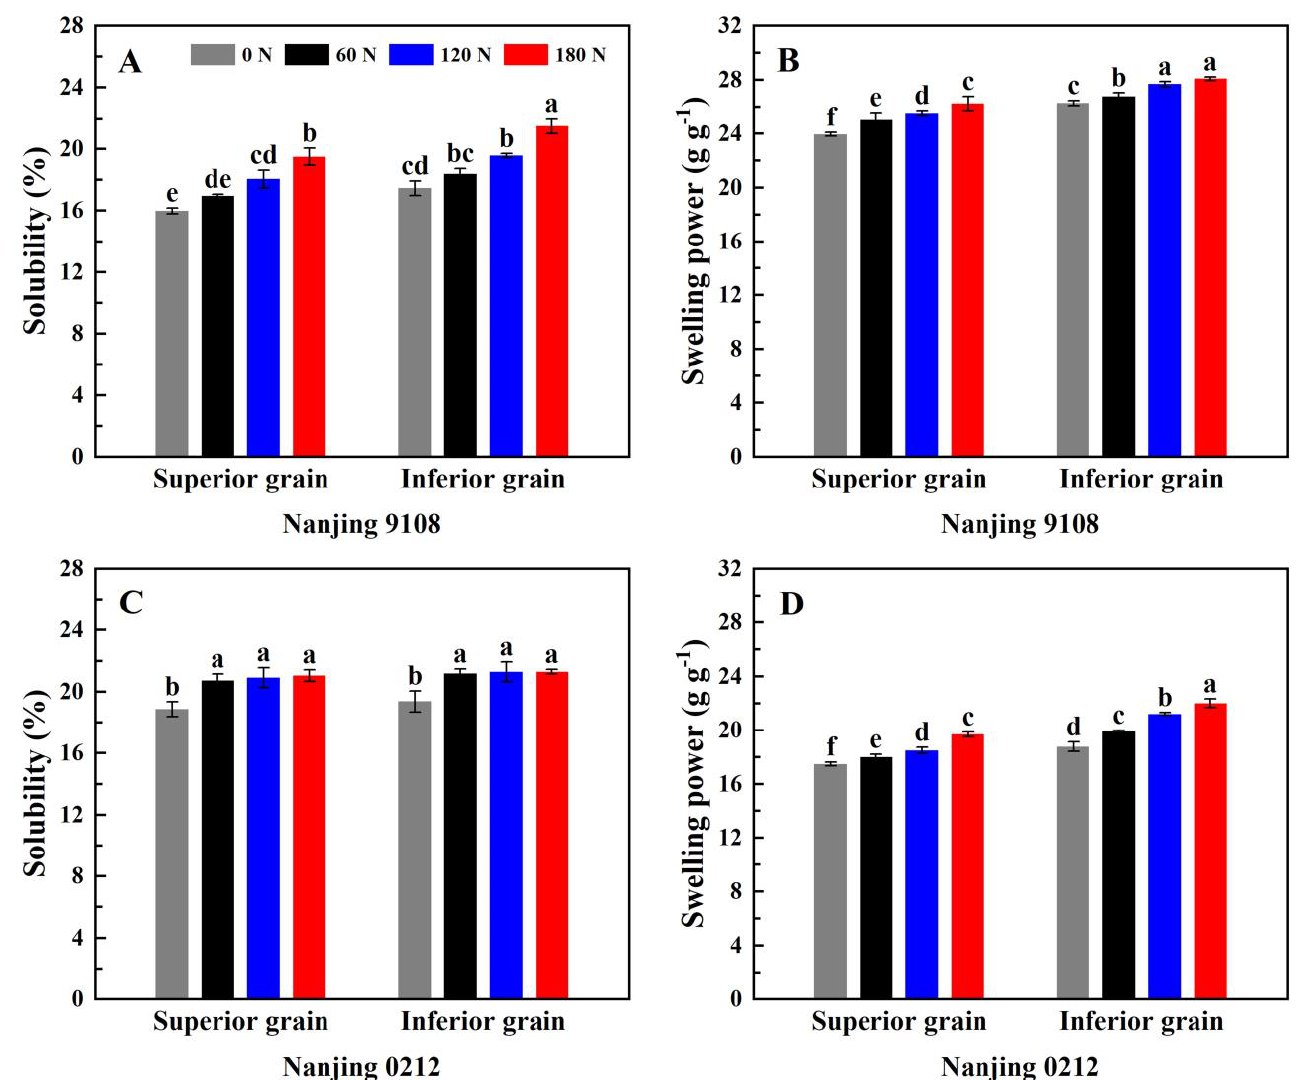
Figure 4. Solubility ( A , C ) and swelling power ( B , D ) of superior and inferior grains of japonica rice under different PNF treatments. Values with different letters are significantly different ( p < 0.05).